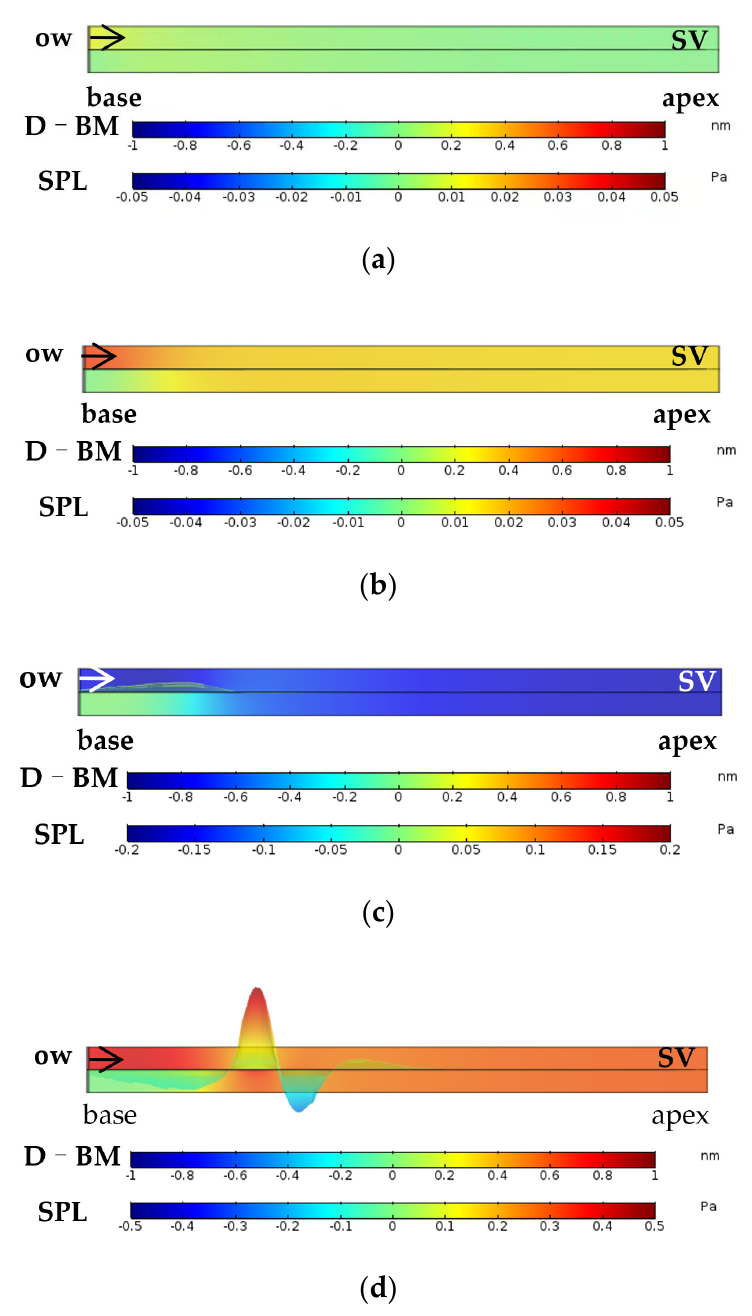
Figure 3. Time domain analysis of the sound pressure level (SPL) of the SV and ST and the displacement of the BM (D–BM) when the OW is excited by a 1 Pa, 5000 Hz pure tone. ( a ) t = 0.03 ms, ( b ) t = 0.06 ms, ( c ) t = 0.17 ms, and ( d ) t = 0.46 ms.